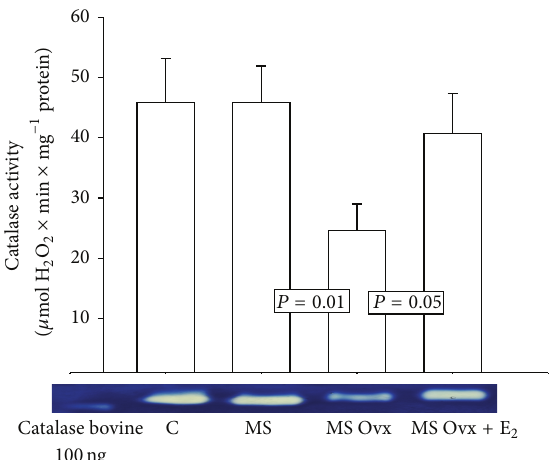
Figure 1: Effect of the estrogen removal and estradiol replace- ment on catalase activity in adipocyte homogenate. Native-gel electrophoresis with 10% polyacrylamide. CAT: catalase, C: control, MS: metabolic syndrome, MS Ovx: metabolic syndrome ovariec- tomized, and MSOvx+E 2 : metabolic syndromeovariectomized plus estradiol. Data are means ± SE; 𝑛 = 8 in each group.